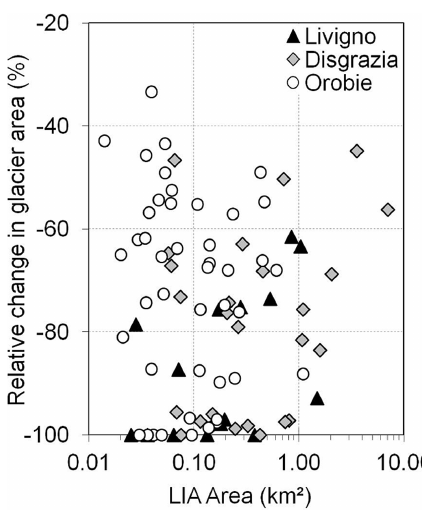
Figure 10. Relative change in glacier area (1860–2007) as a func- tion of former glacier